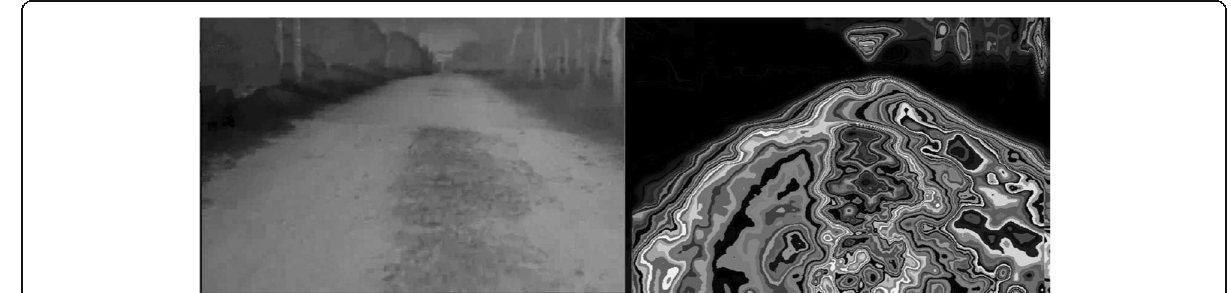
Fig. 13 Backprojection probability map based on road region model. a Original image. b Backprojection probability